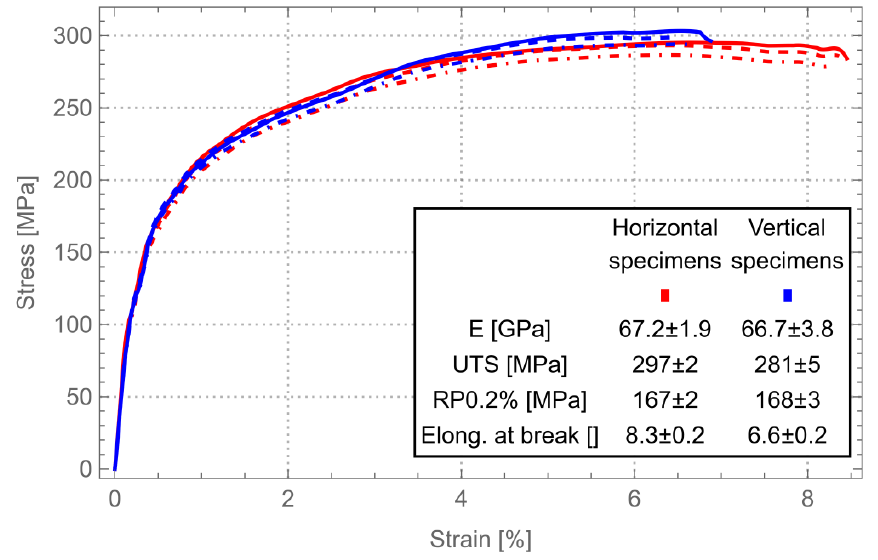
Figure 11. AlSi10Mg σ - ε curve for horizontal and vertical specimens, after Stress Relieving.